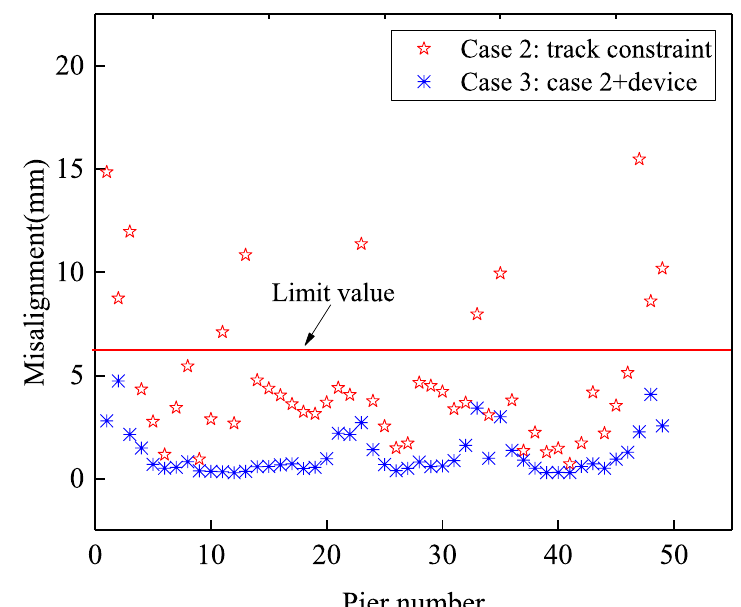
Fig. 15 Maximum misalignment under seismic